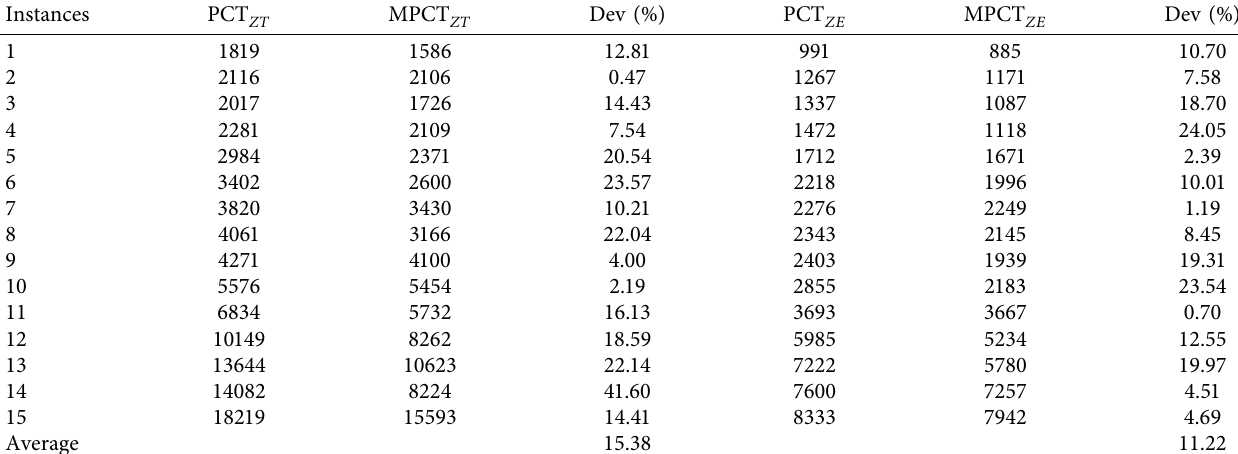
Table 2: Results of MILP-MPCT model vs. PCTs solver.